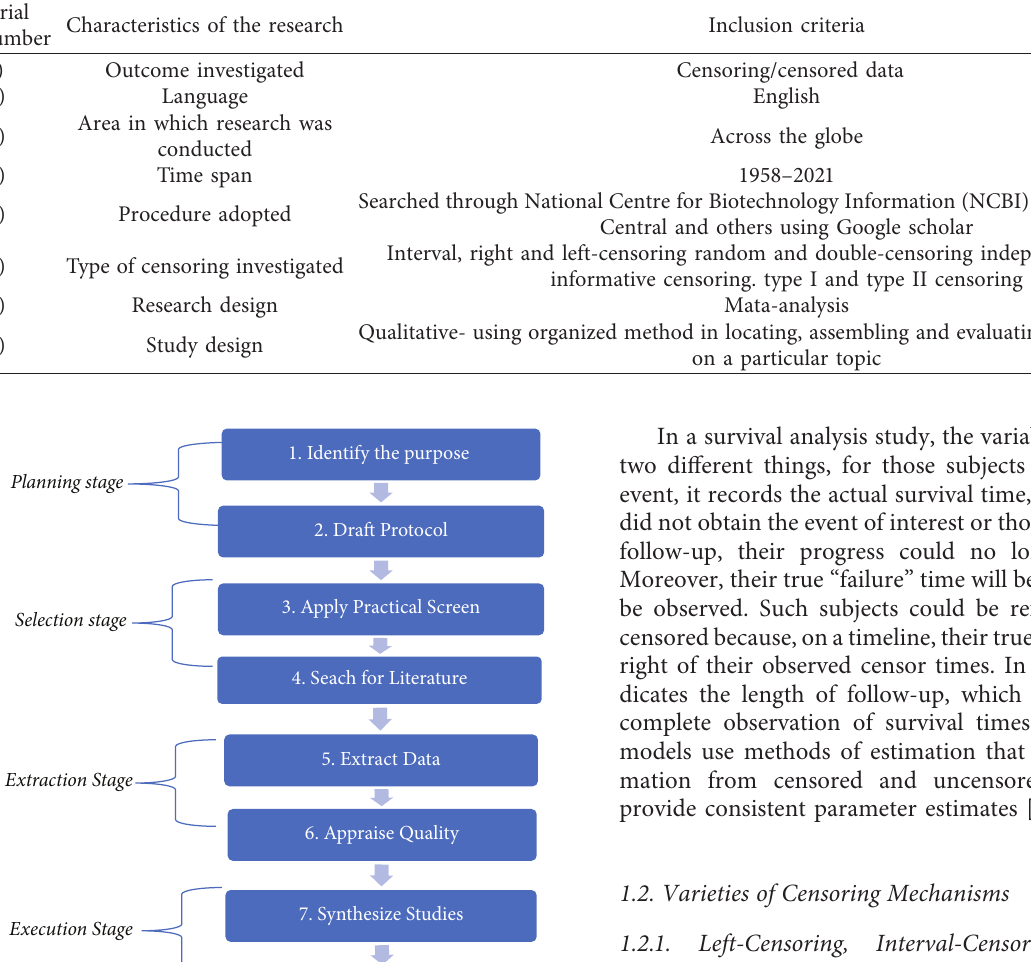
Table 1: A detailed account of the systematic literature review procedure.